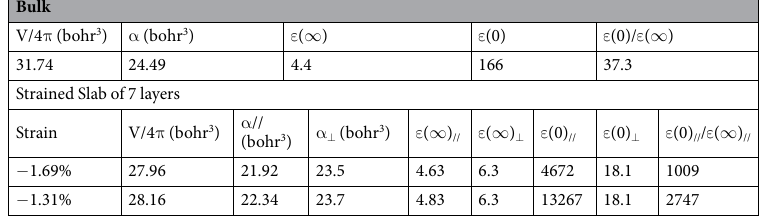
Table 2. Calculated dielectric properties of STO bulk and slab of 7 layers for − 1.69% and − 1.305% strains. The bulk calculated values ε ( ∞ ) = 4.4 and ε (0) = 166 can be compared to the experimental value of 5.6, on the one hand, and to the experimental value of 300 and to the LST based value of 280 from ref. 15, on the other hand.